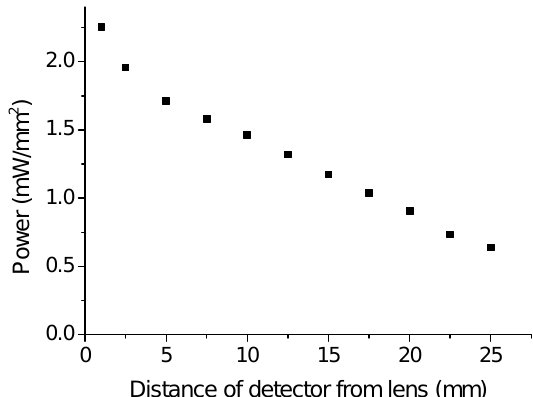
Figure 5. Optical power density over 100 mm 2 versus distance between the detector and the source with 500 mA applied to the